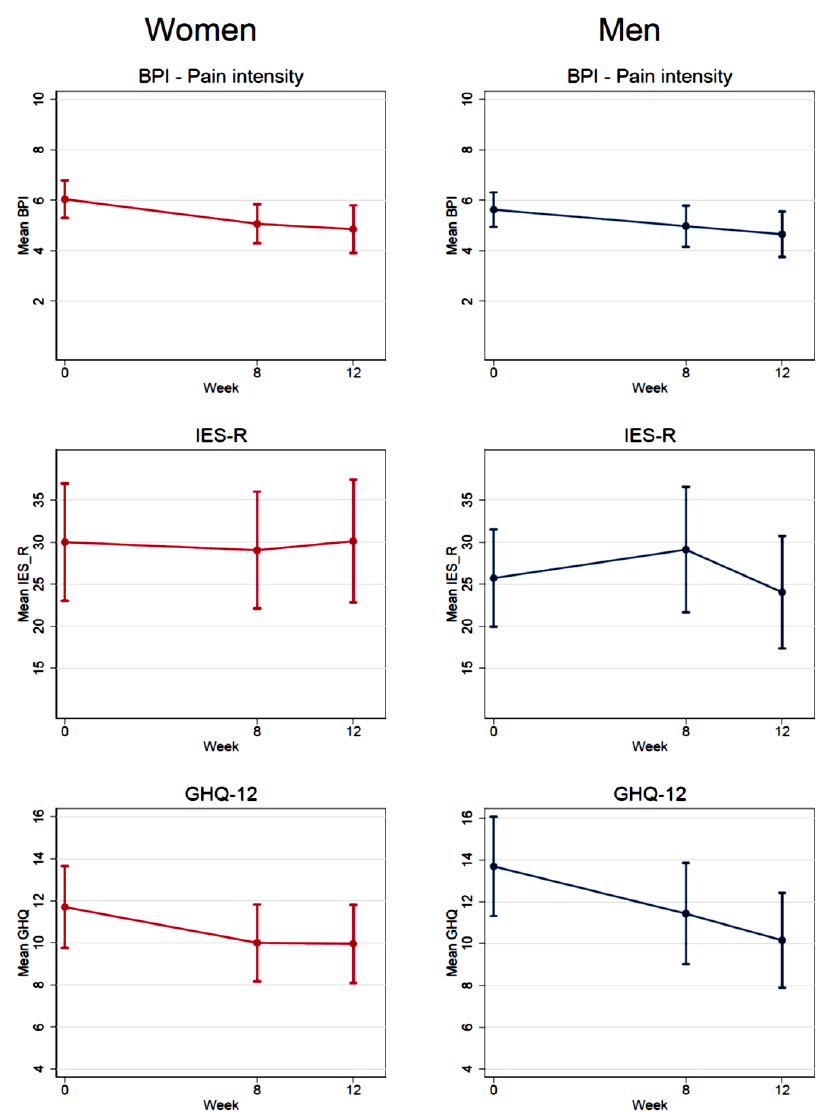
Figure 2. Levels of BPI (pain intensity), IES-R, and GHQ-12 for all participants at different intervals. Note: Week 0 = first PAAI session, week 8= last PAAI session and week 12 = four weeks after last session. Interventions and controls (after participating in the intervention -waitig list-) are presented together, stratified by gender. Mean scores with 95% confidence intervals. Table 1. Characteristics of the intervention and control groups at baseline.